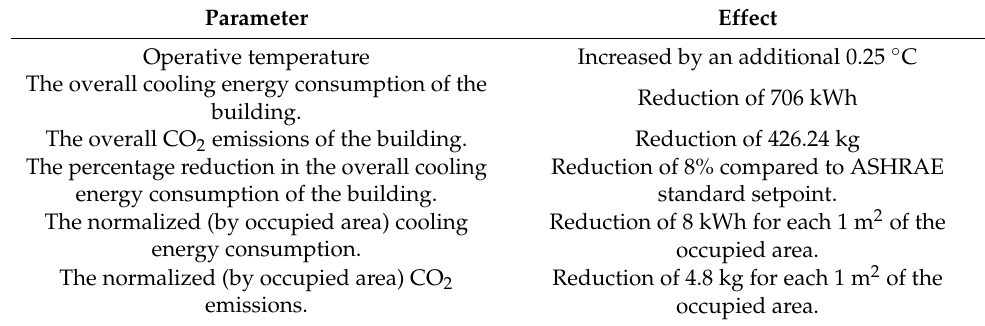
Figure 10. ( A ) The monthly amount of the reduced CO 2 emissions by increasing t s from the ASHRAE-based cooling setpoint (26 ◦ C); ( B ) The sensitivity of the monthly reduced CO 2 emissions ( m CO ) towards the increased cooling setpoint temperature compared to the ASHRAE-based cooling setpoint ( dm CO / dt s ). Table 3. The annual effects of increasing the cooling setpoint temperature by 1 ◦ C.